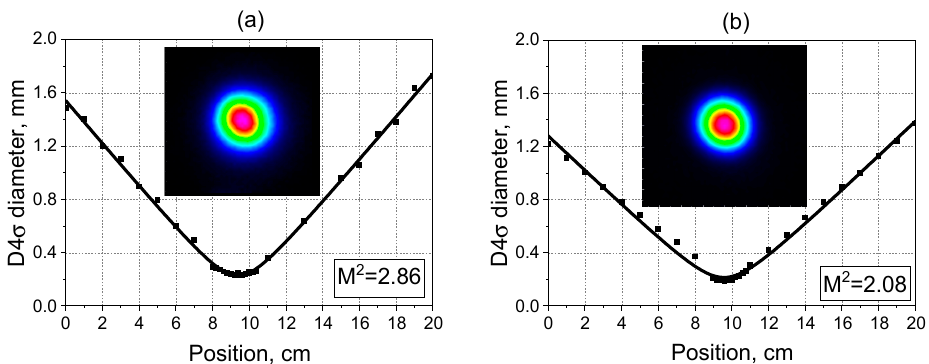
Figure 8. Measured beam quality parameter M 2 of the 1st Stokes (1018 nm) ( a ) and the 2nd